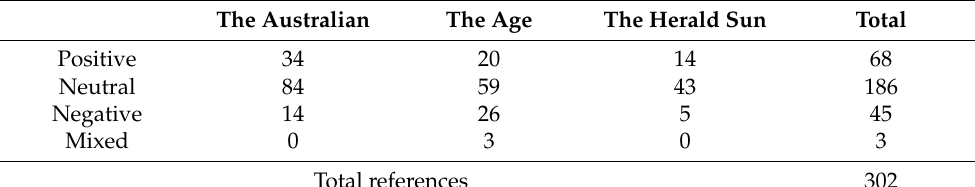
Table 7. Religion (general)—tone of references coded across the newspapers. The Australian The Age The Herald Sun Total